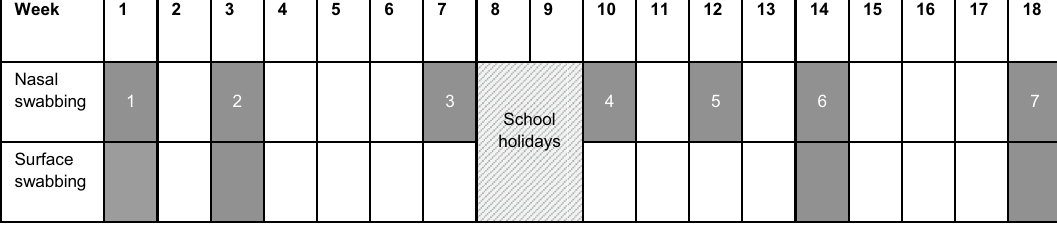
Figure 1. Sample collection